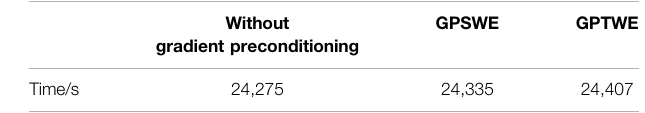
TABLE 1 | Calculation time of LSRTM with 60